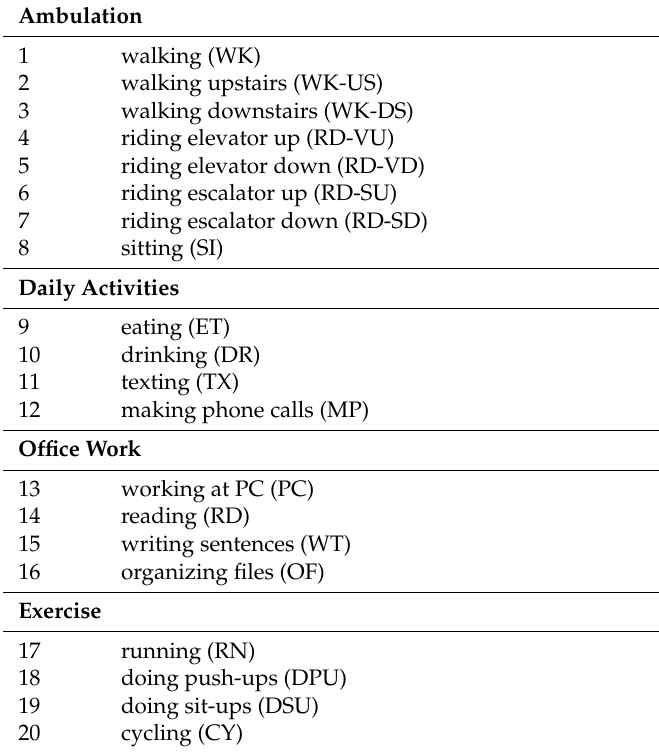
Table 3. The egocentric activities and their corresponding categories in Multimodal